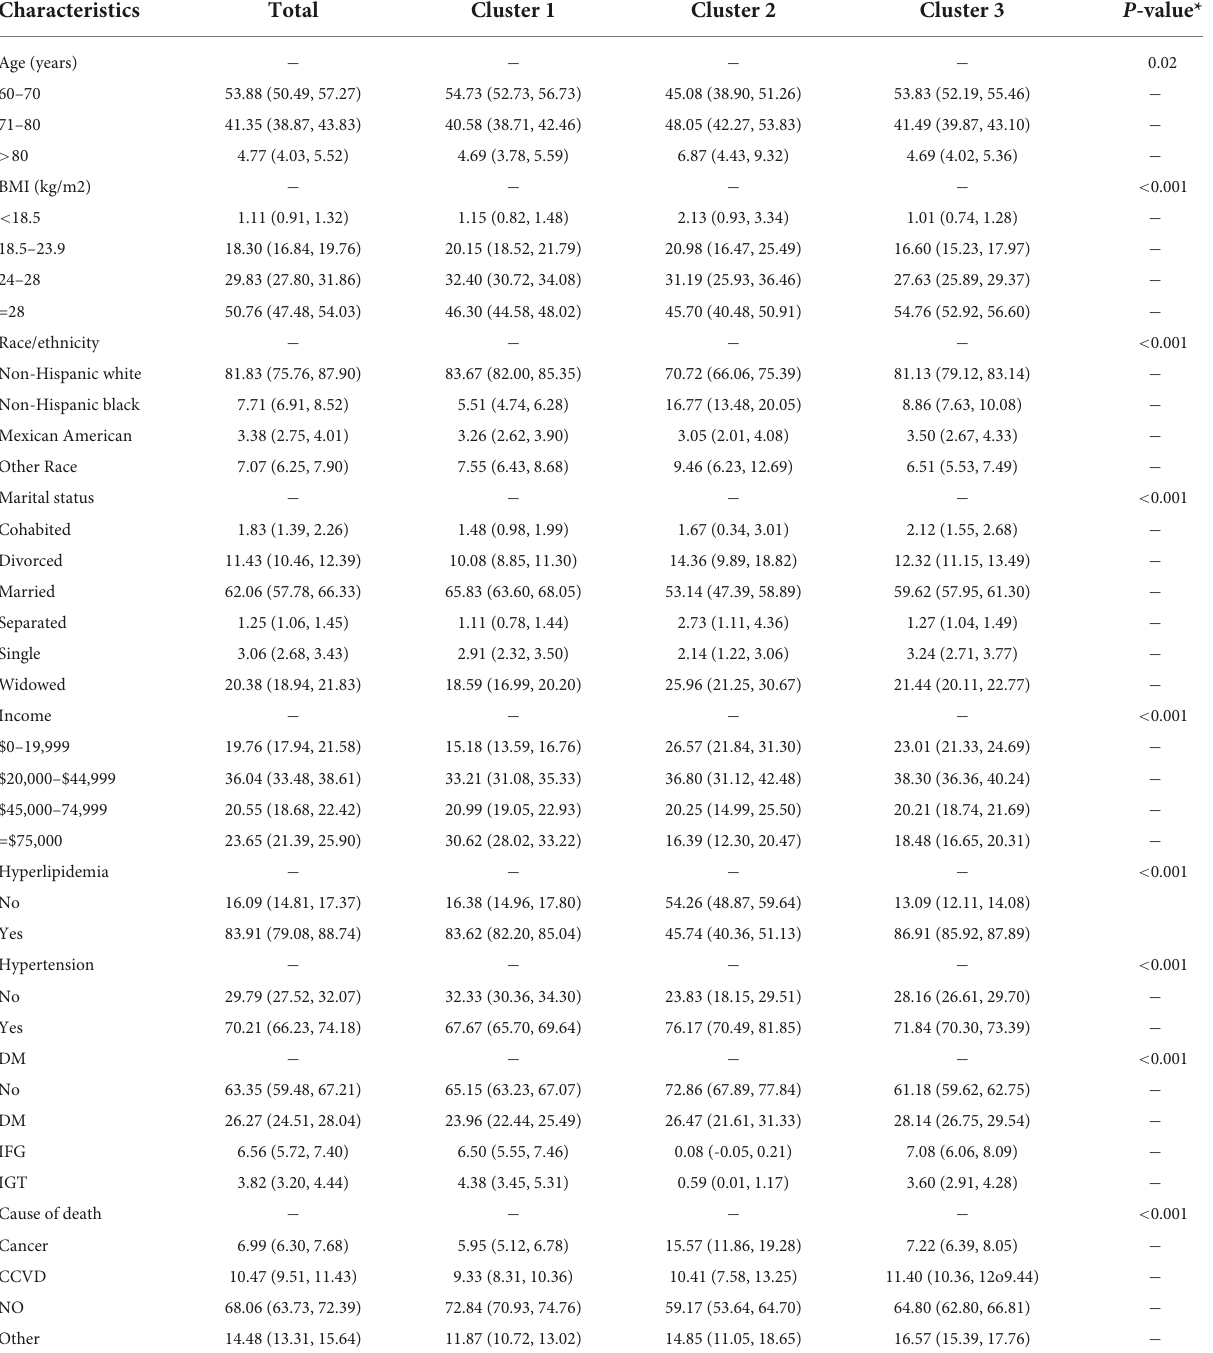
TABLE 3 Baseline characteristics of participants in the national health and nutrition examination survey (NHANES) stratified by the three clusters of nutrition- and diet-related scores.